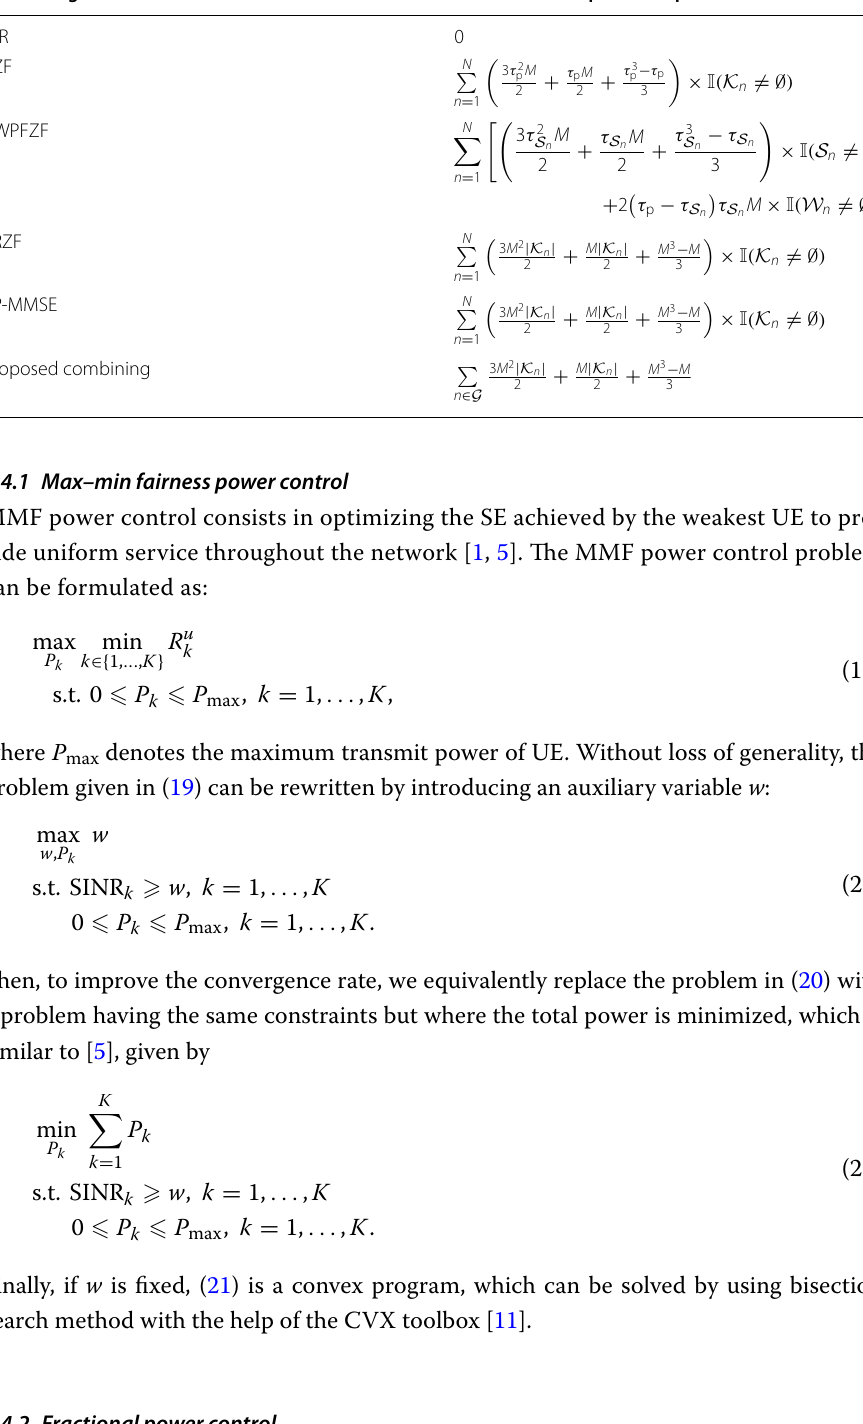
Table 2 Computational complexity Combining scheme Number of complex